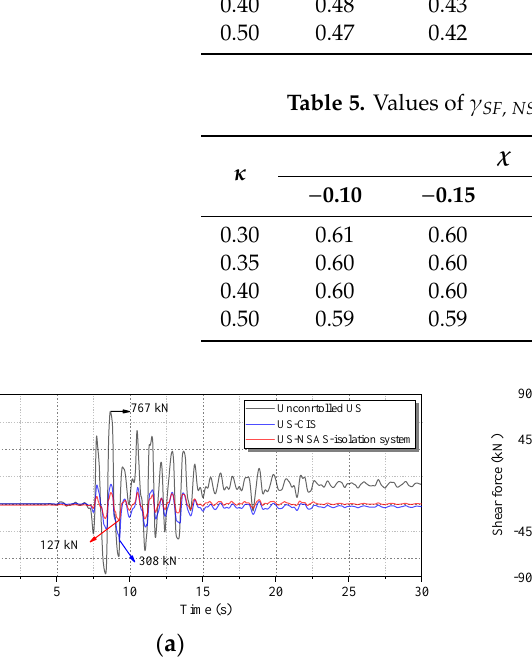
Figure 14. Time series of shear force for uncontrolled underground structure (US), controlled by conventional isolation system (US-CIS) and controlled by negative-stiffness amplification system (US-NSAS)-based isolation system. ( a ) Port Island and ( b ) HIK station records.